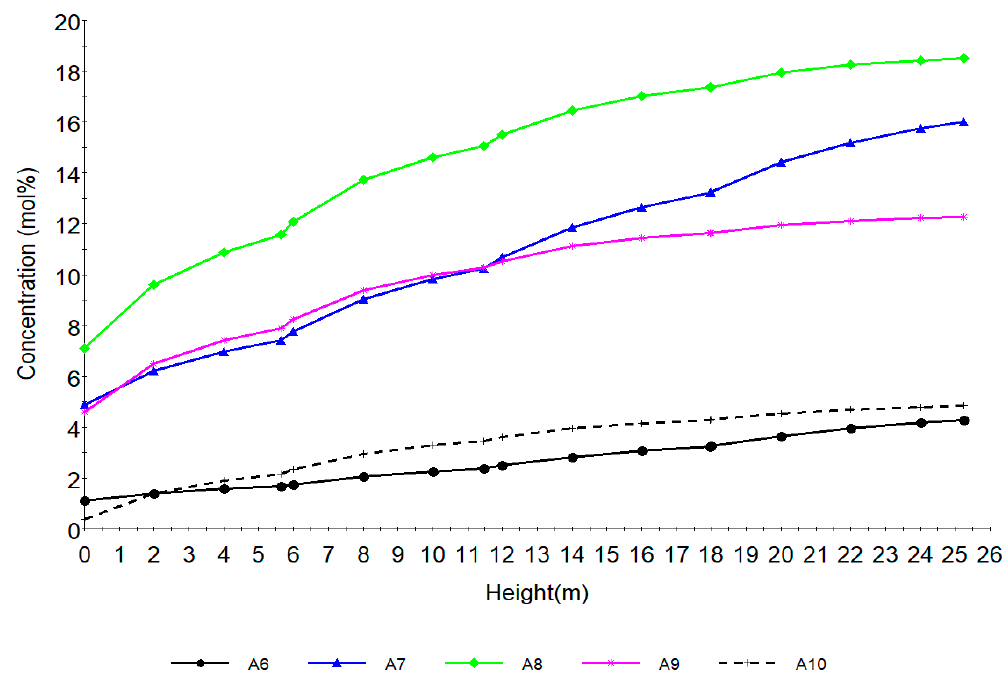
Figure 6. Concentration profile of aromatics with total height of reactors.